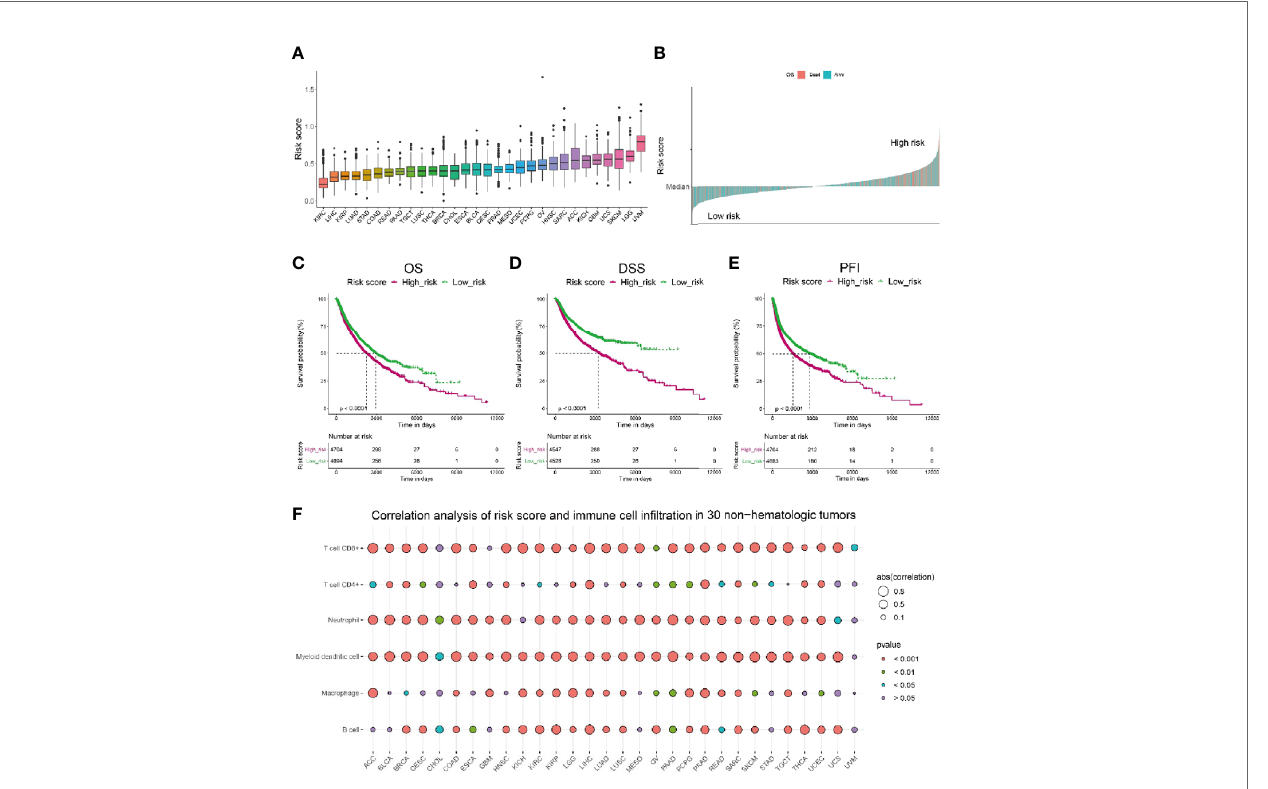
FIGURE 8 | Pan-cancer analysis of the correlation between risk score and immune cell in fi ltration as well as patients ’ survival. (A) Pan-cancer analysis of risk score in 30 non-hematologic tumors. (B) Pan-cancer analysis of risk score indicated patients with high risk (above median) had higher death rate (shown in pink). (C – E) Pan-cancer analysis showed that patients with lower risk score have signi fi cantly longer overall survival (C) , longer disease-speci fi c survival (D) and longer disease-free interval (E) than those with higher risk score. (F) Correlation analysis of risk score and immune cell in fi ltration level in 30 non-hematologic tumors by